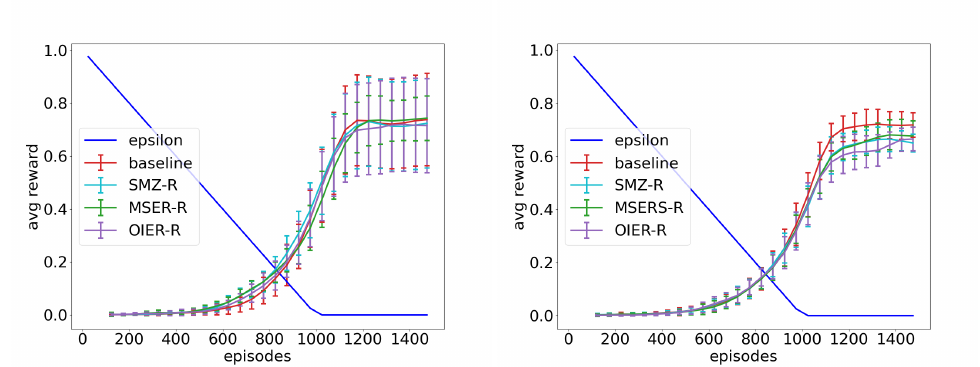
Figure A7. The results for the IER mode: R and t expl = 1000. state encoding: VE. state encoding: CE.